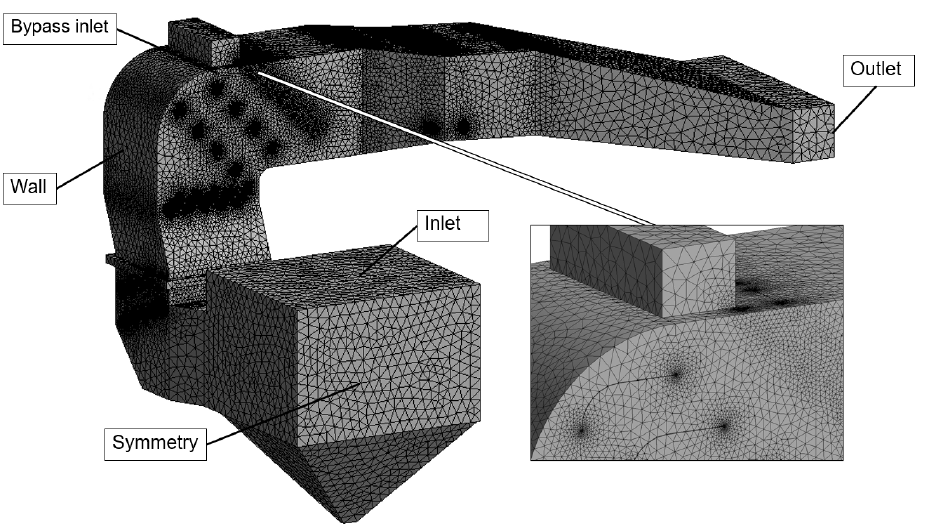
Figure 5. Computational grid of geometry G2 with a zoomed-in view and named selection marked. irregular-shaped flow control elements that significantly influence the simulation